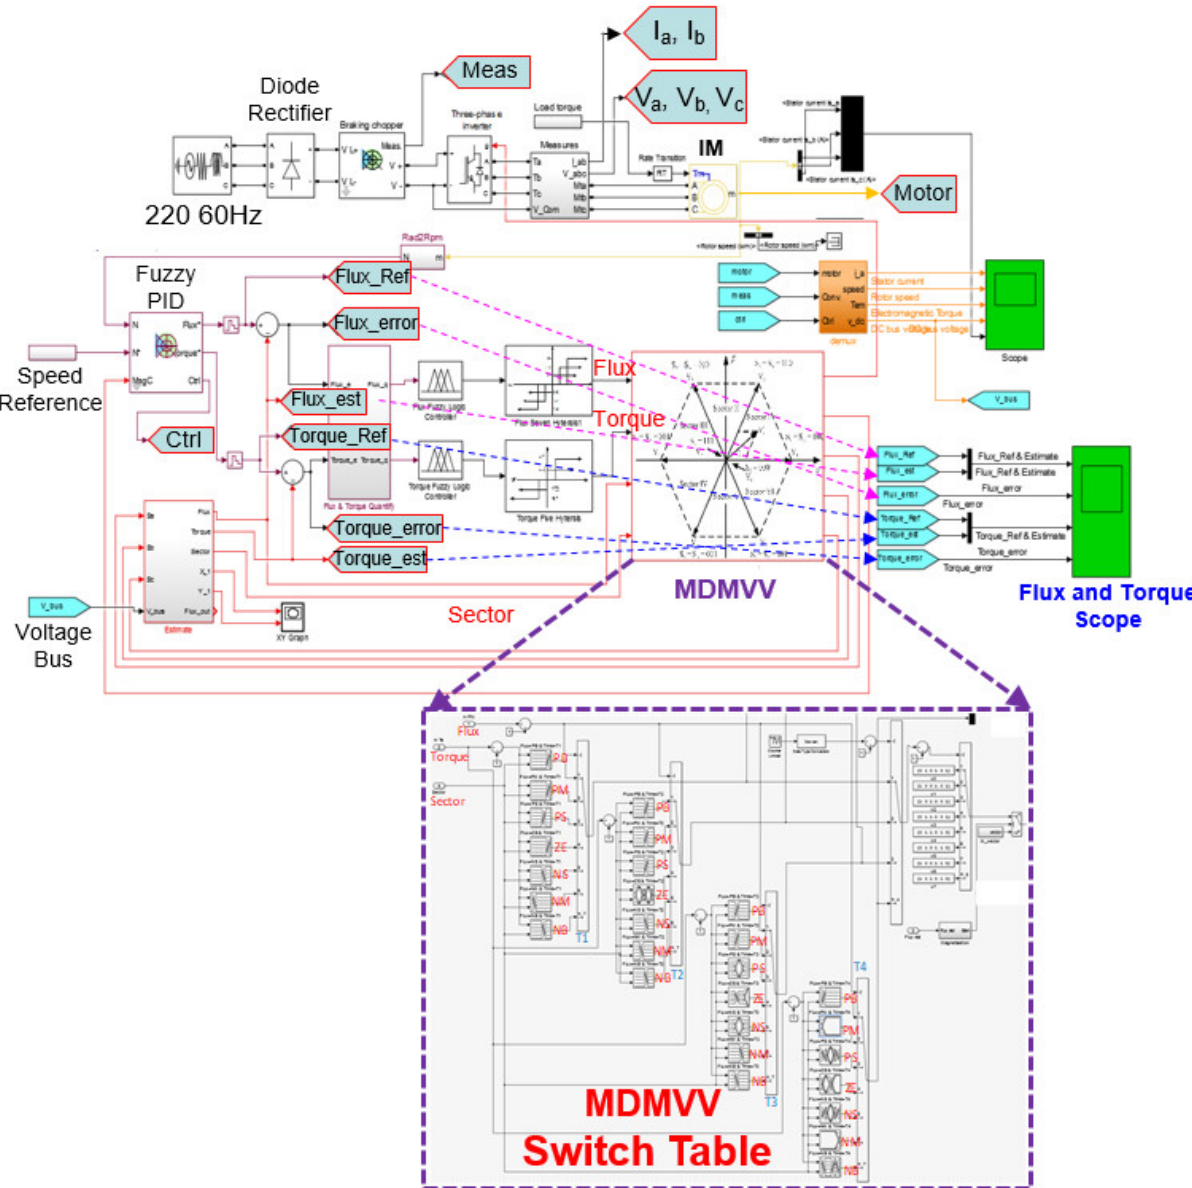
Figure 12. Functional simulation chart of the proposed MPDTC system for a three-phase IM drive.